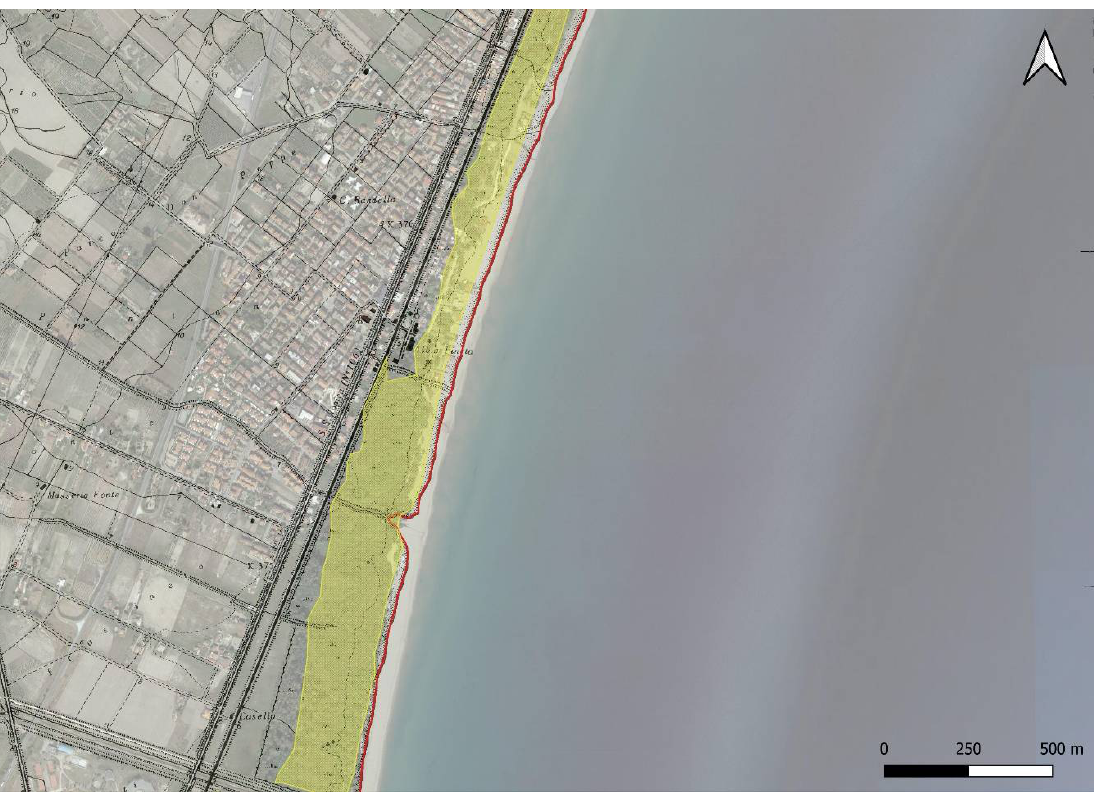
Figure 7. Villapiana: overlap between CASMEZ cartography and the most recent Google satellite image. Legend: red line = shoreline of 1954; yellow dotted area = dune systems of 1950s.